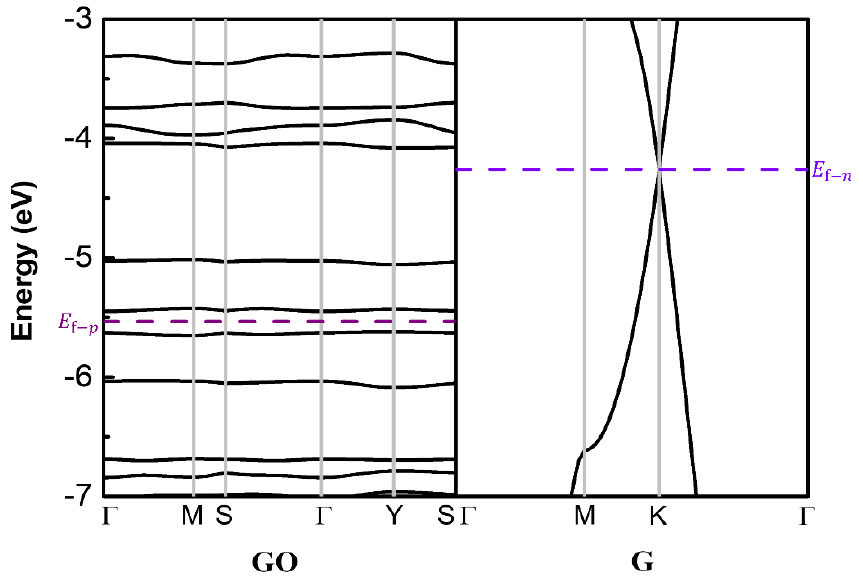
Figure 8. Projected band structure of the model of GO and graphene.